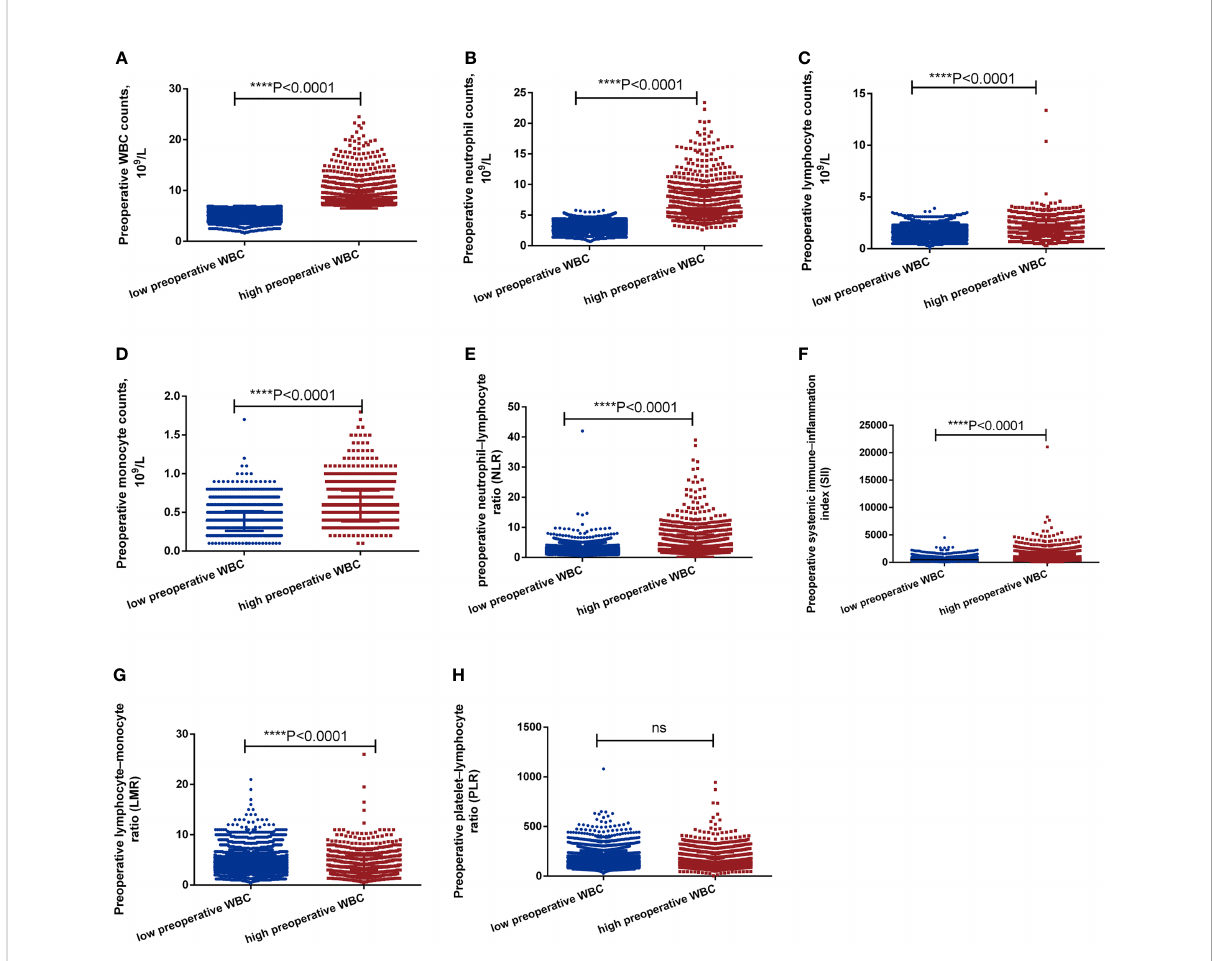
FIGURE 2 The level of in fl ammation-related biomarkers between high preoperative WBC group and low preoperative WBC group before matching. (A-H) . The level of WBC, neutrophils, lymphocyte, monocyte, NLR, PLR, LMR, SII between high preoperative WBC group and low preoperative WBC group before matching. Differences were considered signi fi cant at **** P < 0.0001, compared to the low preoperative WBC group. ns, no signi fi